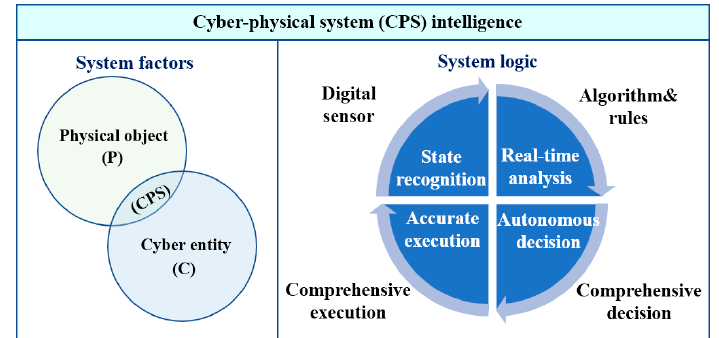
Figure 8. CPS intelligence (Type II).